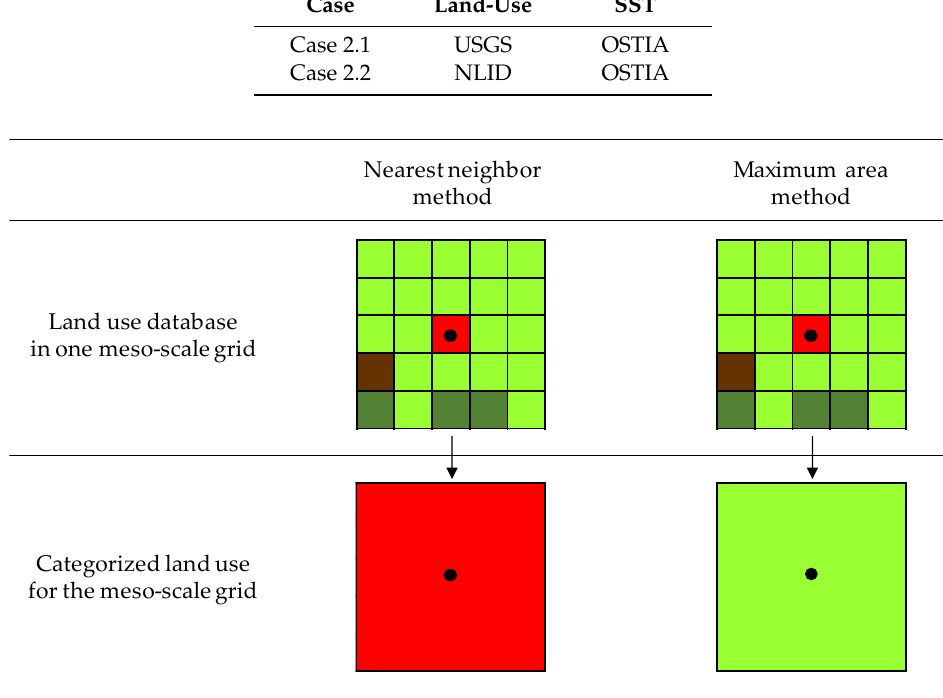
Table 4. Cases used to investigate the effect of land-use.